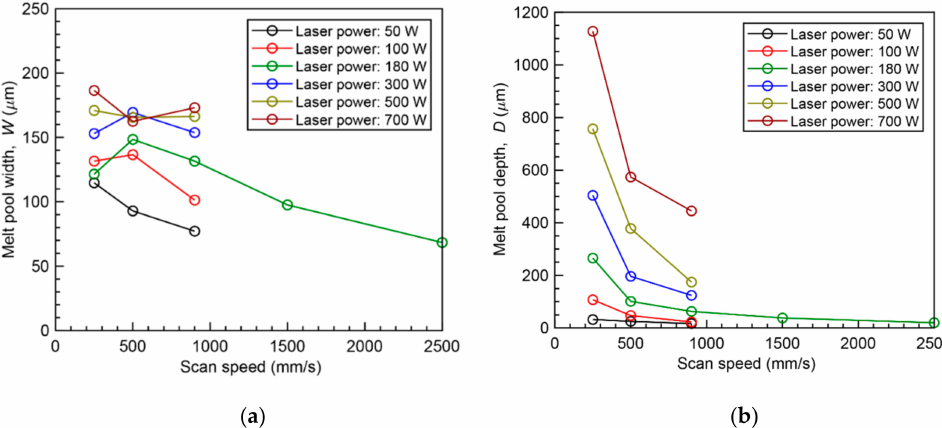
Figure 7. Relationship between melt pool dimensions and laser scan condition: ( a ) Melt pool width, W ; ( b ) Melt pool depth, D